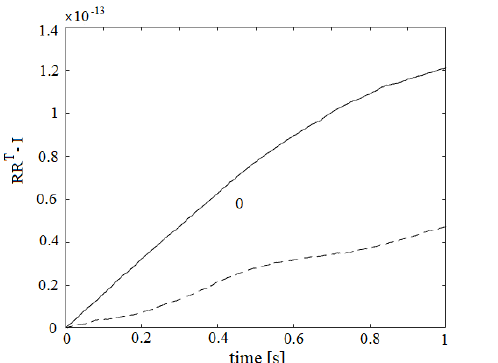
Figure 3. Frobenius norm of the difference between R ( t ) R ( t ) T and the identity matrix for the trajectories shown in Figure 4a (dashed) and Figure 5a (solid).